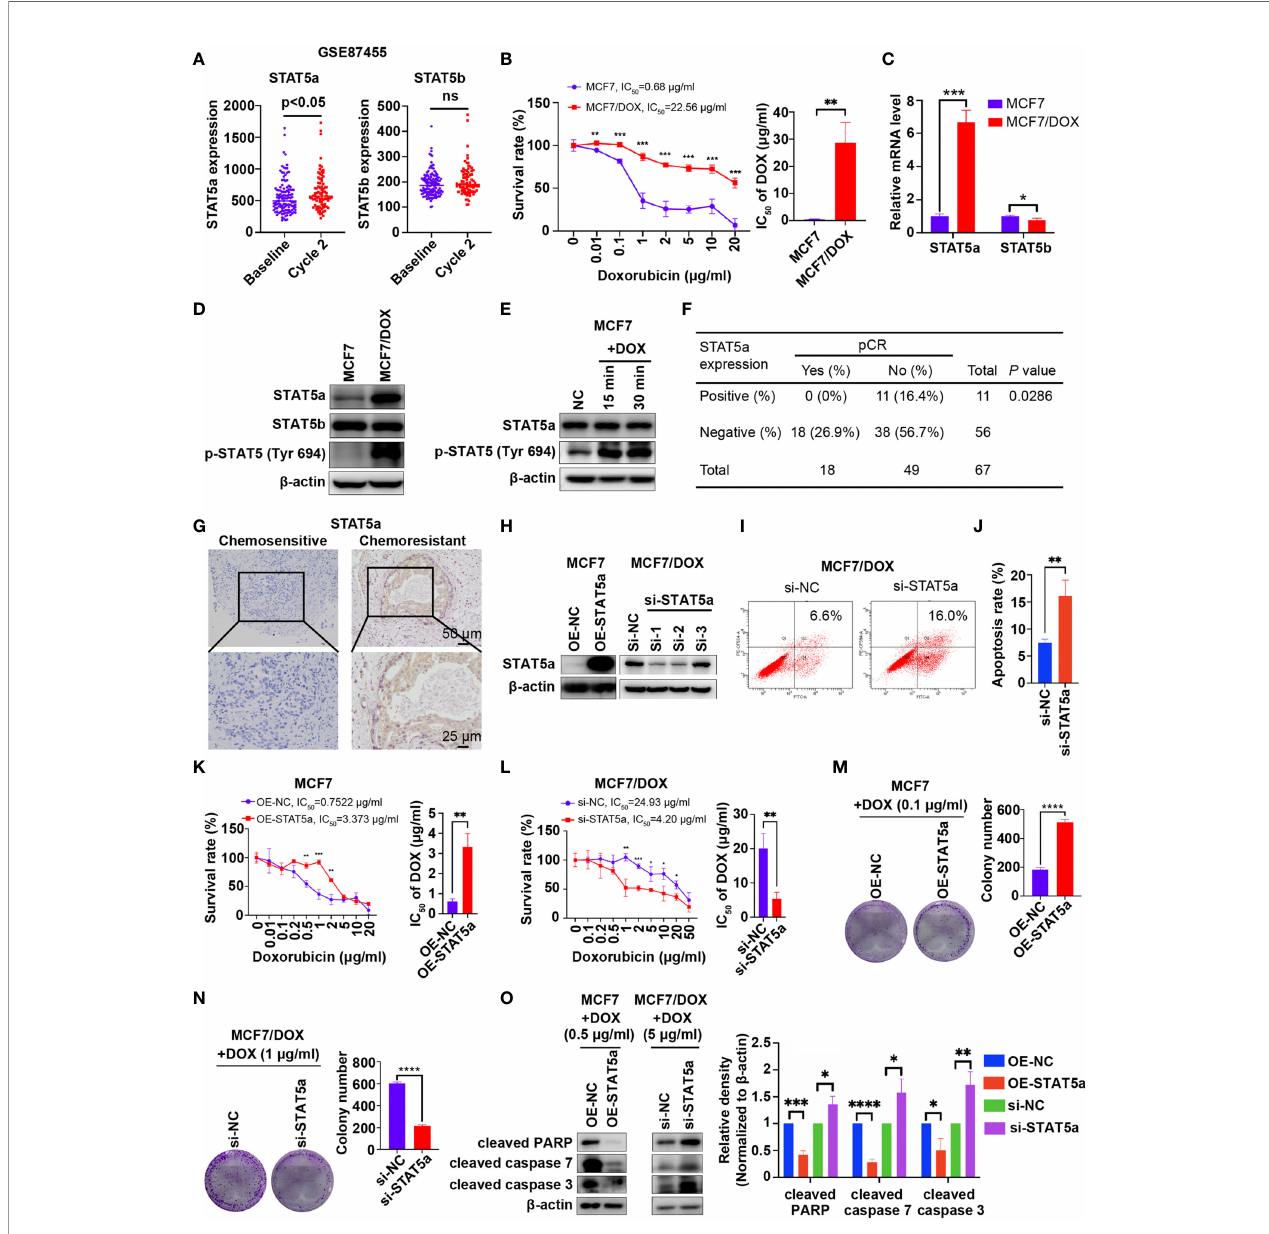
FIGURE 1 | STAT5a is involved in chemoresistance in breast cancer. (A) Expression of STAT5a and STAT5b in breast cancer samples collected pre- and postchemotherapy in the dataset GSE87455. (B) Survival rates of MCF7 and MCF7/DOX cells after treatment with DOX for 48 h determined by a CCK8 assay. (C) mRNA levels of STAT5a and STAT5b in MCF7 and MCF7/DOX cells assessed via qPCR. (d) Protein levels of STAT5a, p-STAT5a (Tyr694) and STAT5b in MCF7 and MCF7/DOX cells determined by Western blotting. (E) Western blotting was performed to examine the expression of STAT5a and p-STAT5 (Tyr694) in CF7 cells upon treatment with DOX. (F) Correlation between the pCR rate and STAT5a expression in breast cancer samples obtained from 67 patients. (G) Representative images of IHC staining for STAT5a in chemoresistant and chemosensitive breast cancer samples. (H) Ef fi ciency of vector transfection for overexpression of STAT5a in MCF7 cells and siRNA transfection for knockdown of STAT5a in MCF7/DOX cells determined by Western blotting. (I, J) Flow cytometry was performed to assess apoptosis in MCF7/DOX cells after knocking down STAT5a or control treatment (I) . Bar graphs showing the percentage of apoptotic cells (J, K) Survival rate and IC50 of MCF7 cells transfected with an empty vector or a STAT5a vector after treatment with DOX for 48 h determined by a CCK8 assay. (L) Survival rate and IC50 of MCF7/DOX cells transfected with scramble siRNA or STAT5a-targeting siRNA after treatment with DOX for 48 h determined by a CCK8 assay. (M, N) Representative images and quanti fi cation of colonies formed by MCF7 cells transfected with the empty vector or STAT5a vector (M) and MCF7/DOX cells transfected with scramble siRNA or STAT5a-targeting siRNA (N) in medium containing the indicated concentration of DOX. (O) The expression levels of apoptosis markers in MCF7 cells transfected with the empty vector or STAT5a vector and MCF7/DOX cells transfected with scramble siRNA or STAT5a-targeting siRNA under treatment with the indicated concentration of DOX determined by Western blotting. ns, p > 0.05; *p < 0.05; **p < 0.01; ***p < 0.001; ****p <